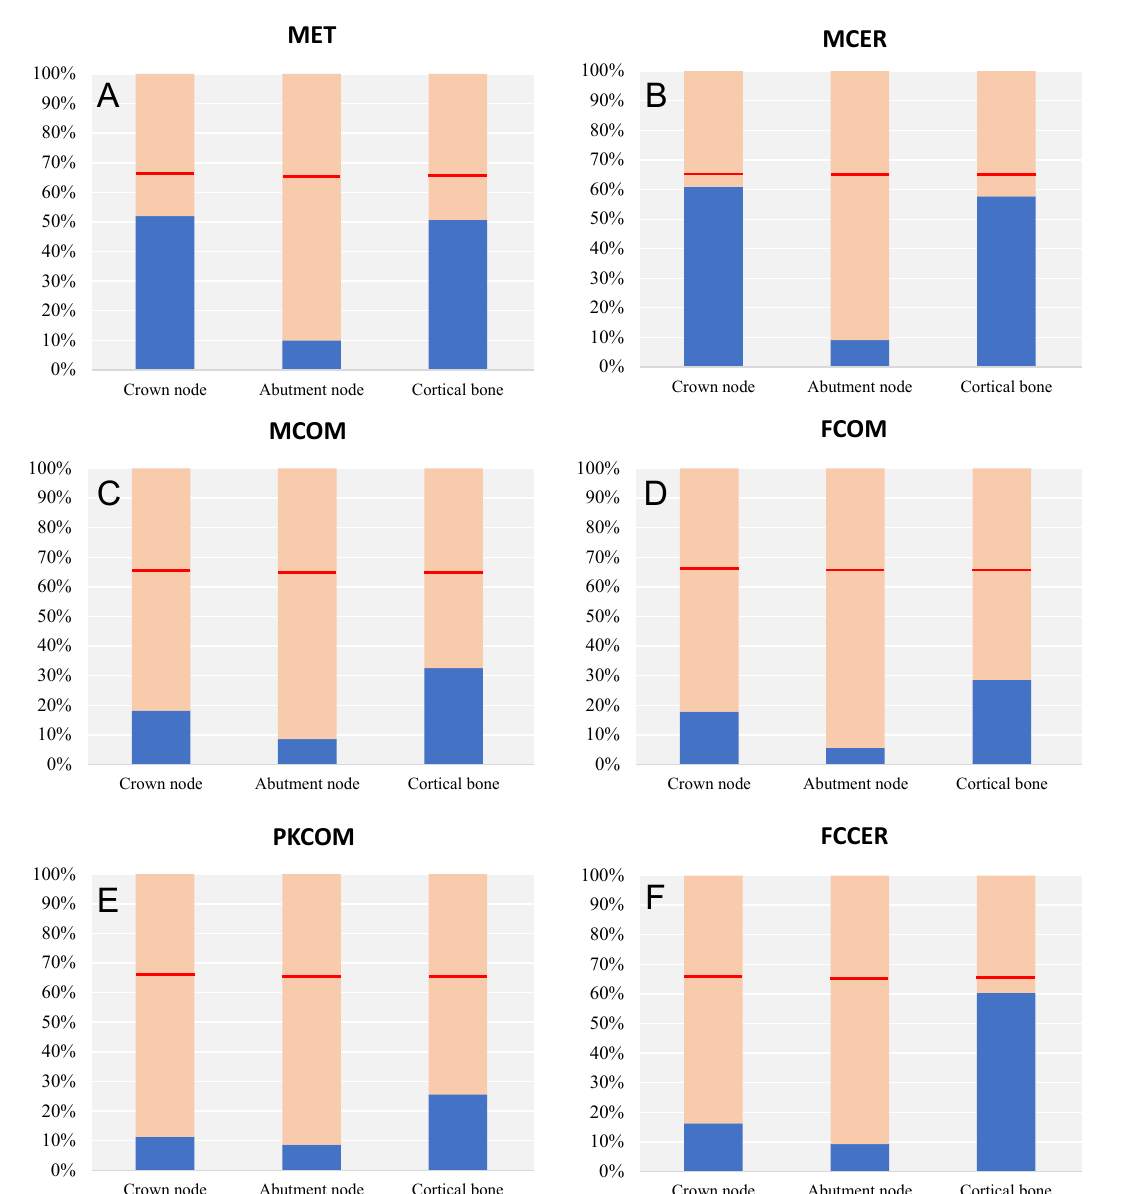
Figure 7. Comparison of the yield strength ratio depending on the node and crown material.